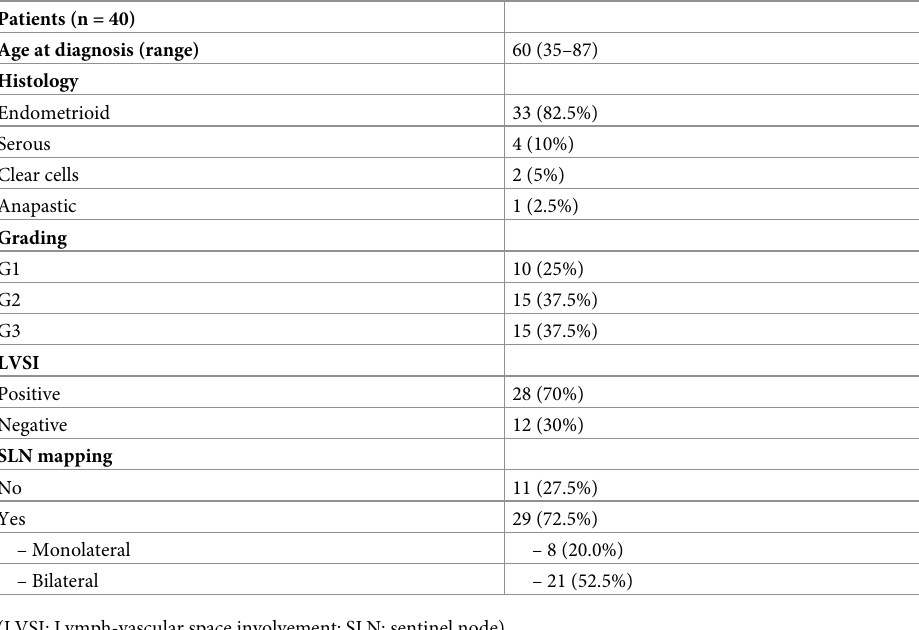
Table 1. Demographics and baseline